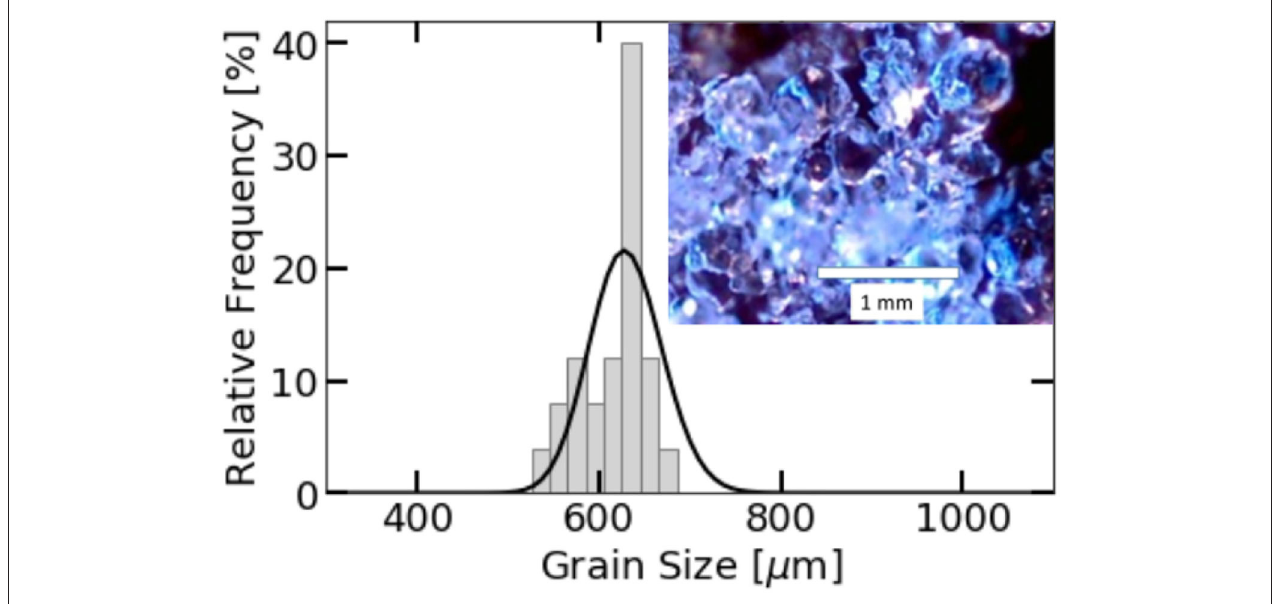
FIGURE 5 | Distribution of the snow grain diameters. Three microscopic snow images of the loose, unsintered snow grains (inset) are analyzed and snow grain sizes are estimated from the microscopic images. From the resulting diameters a histogram is calculated (gray barplot) that is approximated by a smooth, normalized grain size distribution (black line) using Equation